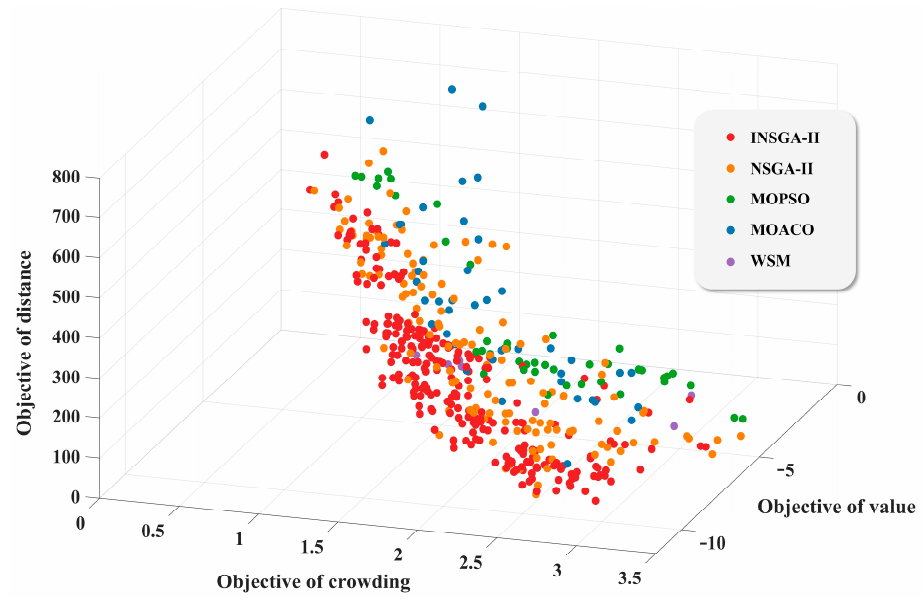
Figure 12. The final non-dominated solutions from different methods (an example of tourist #12).